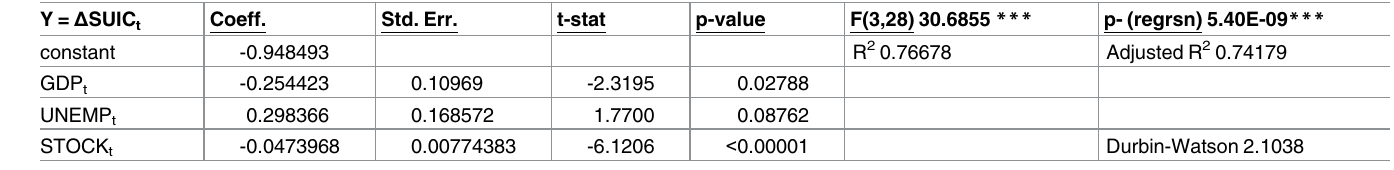
Table 2. Change in suicide rate: Model #2 OLS regression between the marketrisk premium (STOCK t ), the unemployment rate (UNEMP t ), the real GDP growth rate (GDP t ) and rate of change in annual suicides (Y-variable). The overall regressionF-stat is 30.69 and significantat the 0.001 p-value. The Durbin-Watson test value of 2.1038 indicatesno autocorrelation in the regressionresiduals. The adjustedR 2 indicatesthat 74.18% of the variationin the changein suiciderate is explained by the three independentvariables. Annualrates are since 1980. Data from [9], [10]. Y = Δ SUIC t